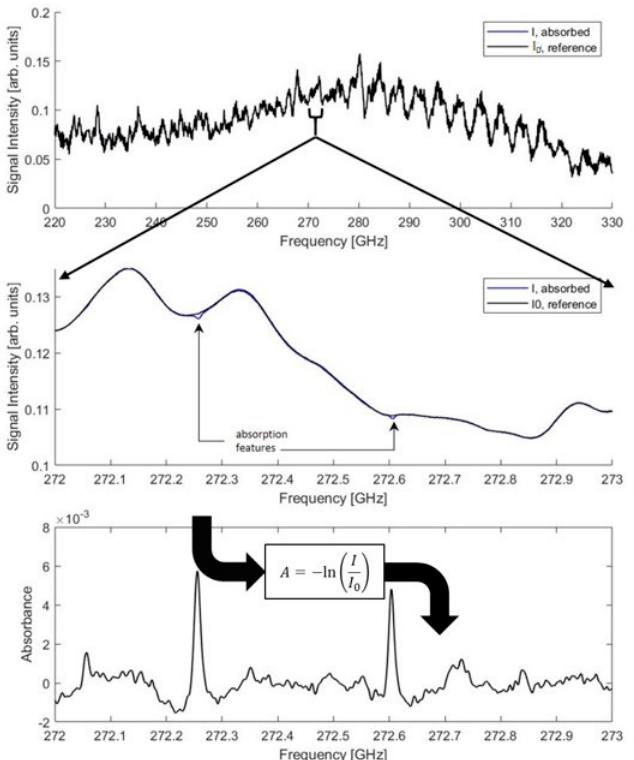
Figure 3. Example experiment: 0.4 Torr (53 Pa) pure DMSO at 297 K. Top panel: reference and absorbed intensity in total frequency range (220–330 GHz); middle panel: reference and absorbed intensity in subset of frequency range (272–273 GHz); bottom panel: absorbance in subset of frequency